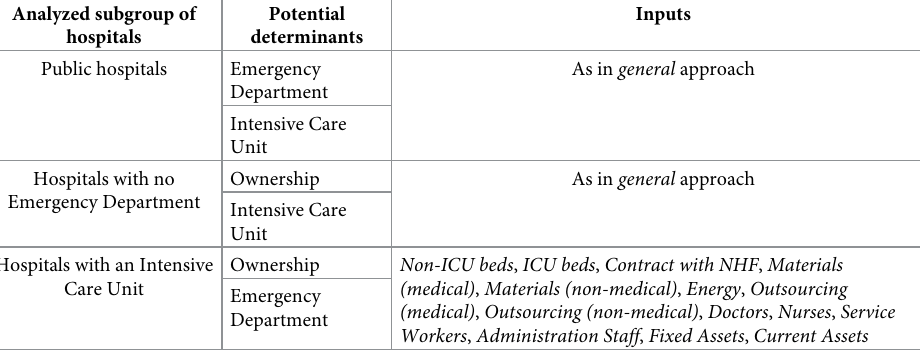
Table 1. Inputs and potential determinants by subgroup of